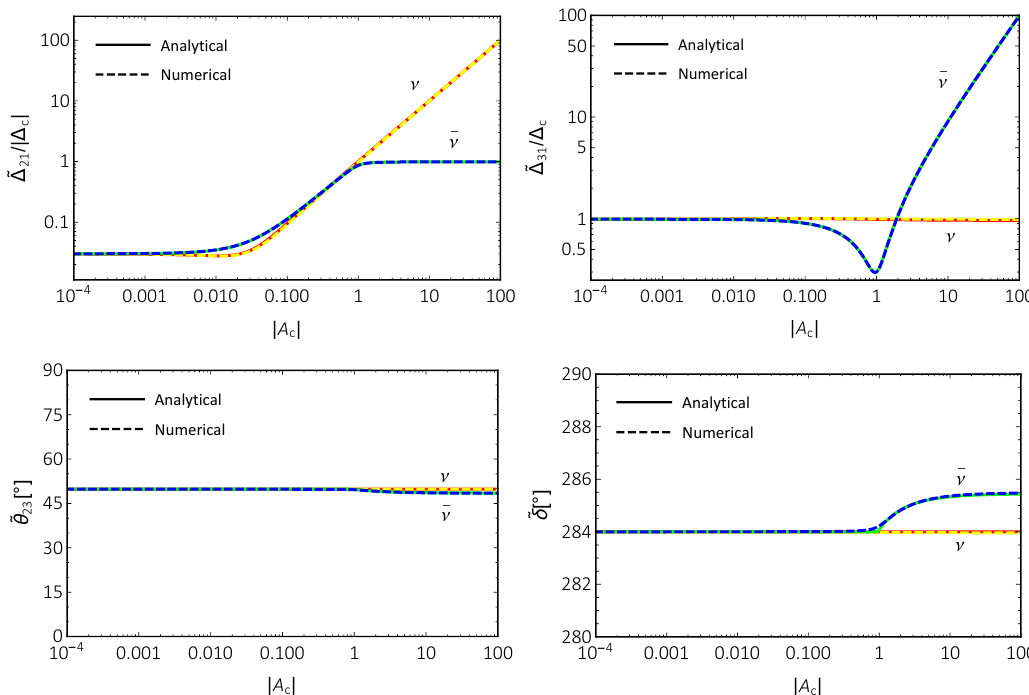
= j (cid:1) j ; e (cid:1) = (cid:1) g are shown in the (cid:12)rst row c c 21 31